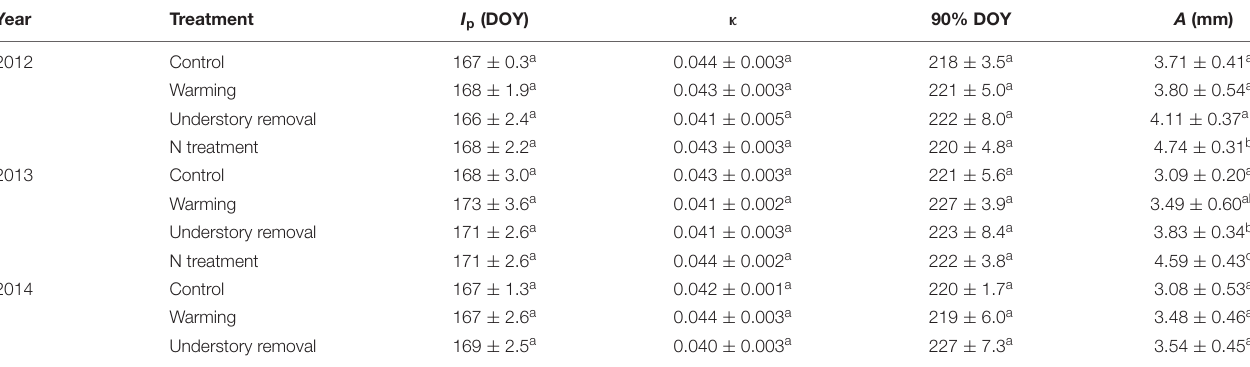
TABLE 3 | Parameters of the Gompertz function (Mean ± SD) for intra-annual radial growth of Pinus cembra trees selected for dendrometer records in 2012, 2013, and